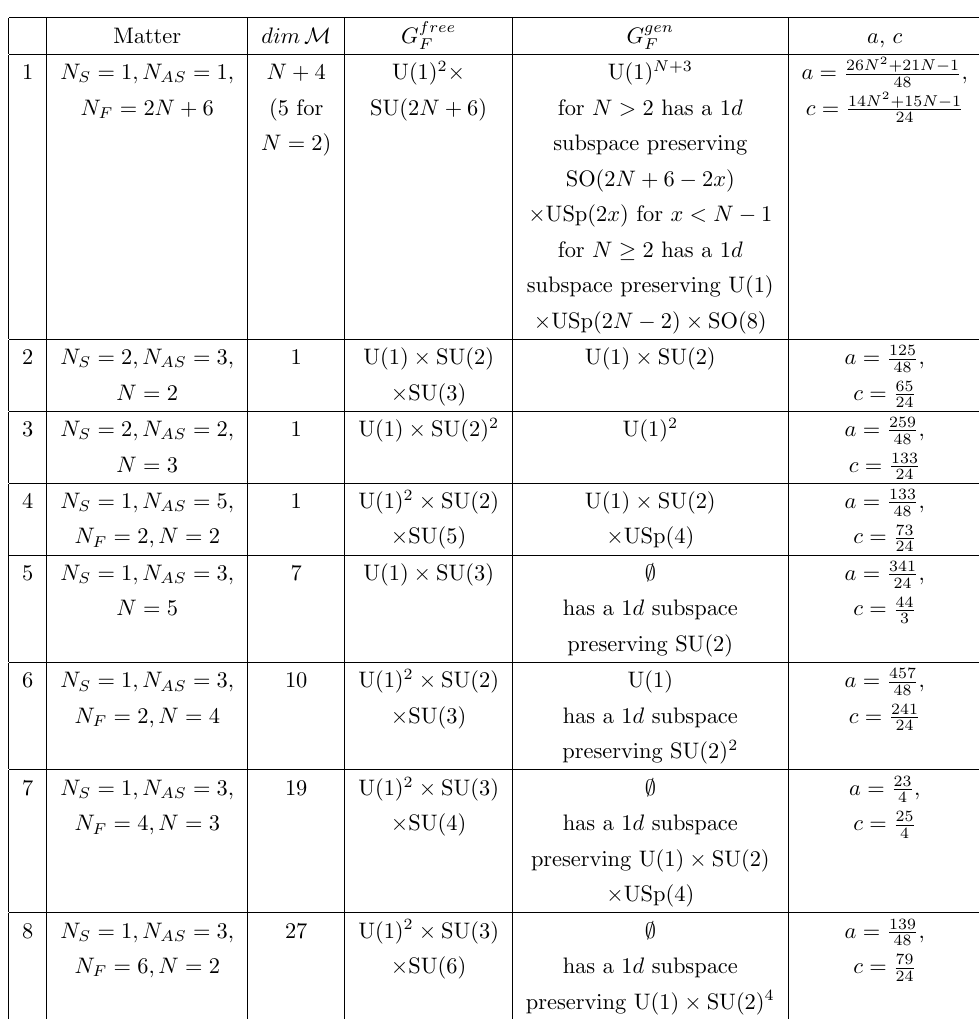
Table 12 . Cases involving a USp(2 N ) gauge group with symmetric chiral